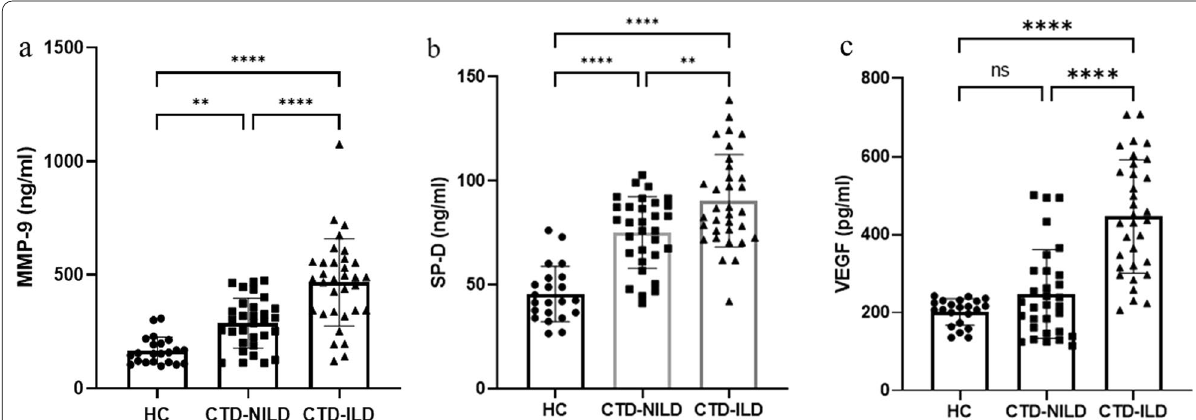
Table 3 Correlation analysis of serum marker level and traditional laboratory indicators in CTD-ILD Indicators